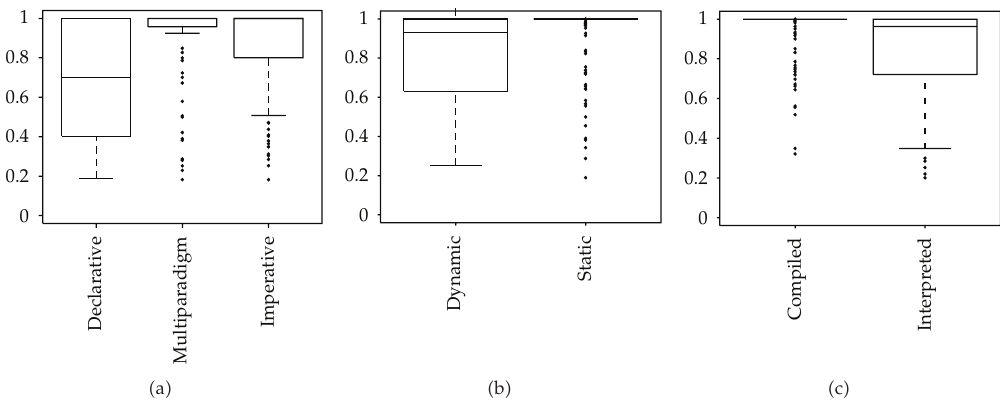
Figure 5: E ffi ciency of groups of languages: imperative versus declarative versus multiparadigm, static versus dynamic, compiled versus